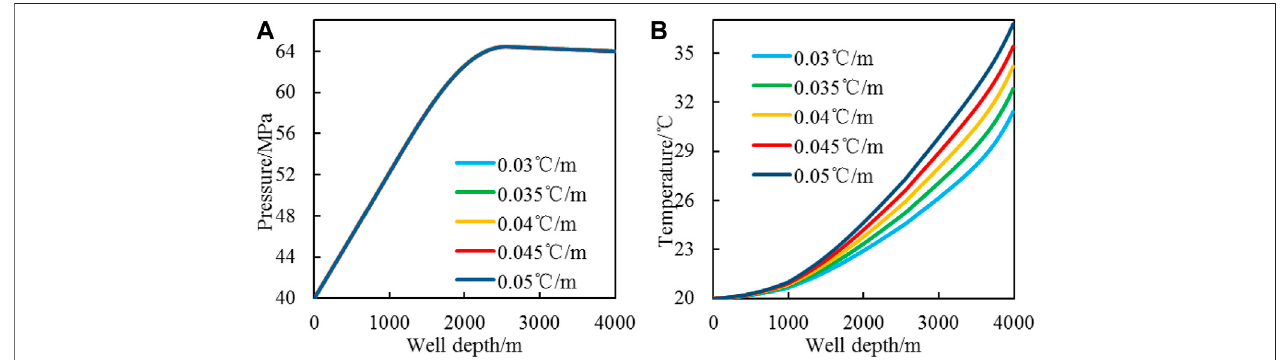
FIGURE 12 | CO 2 foam fracturing fl uid pressure and temperature change with geothermal gradient [ (A) : pressure pro fi le; (B) : temperature pro fi le].